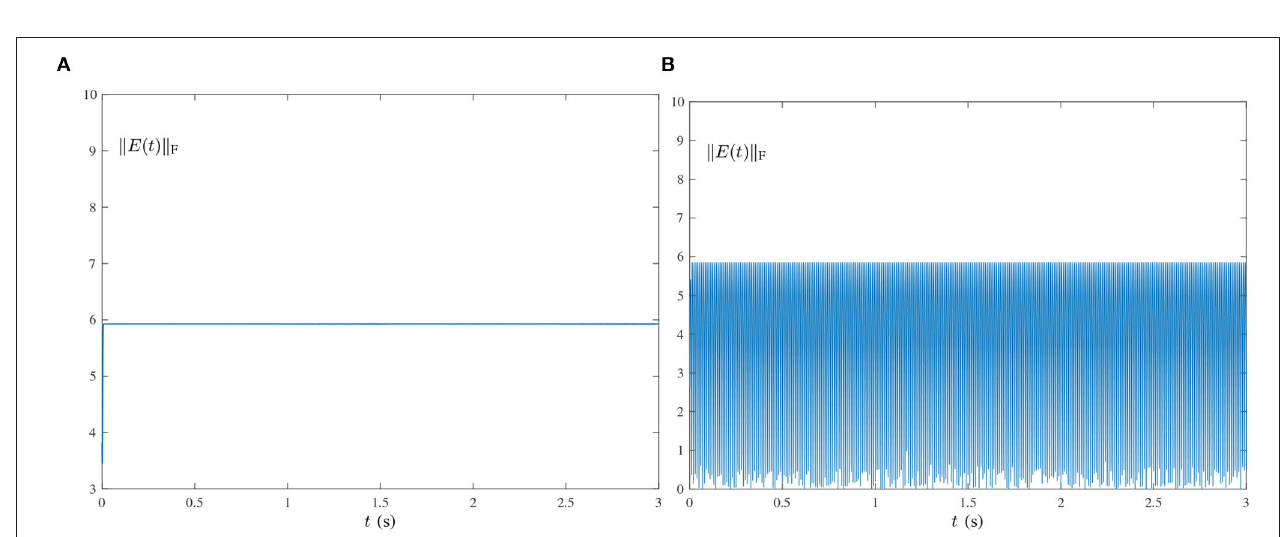
FIGURE 2 | Residual errors of ZNN-1 model (24) for computing the pseudoinverse of the dynamic matrix (21) under the single-harmonic noise with different frequencies. (A) f = 0.001 Hz. (B) f = 50